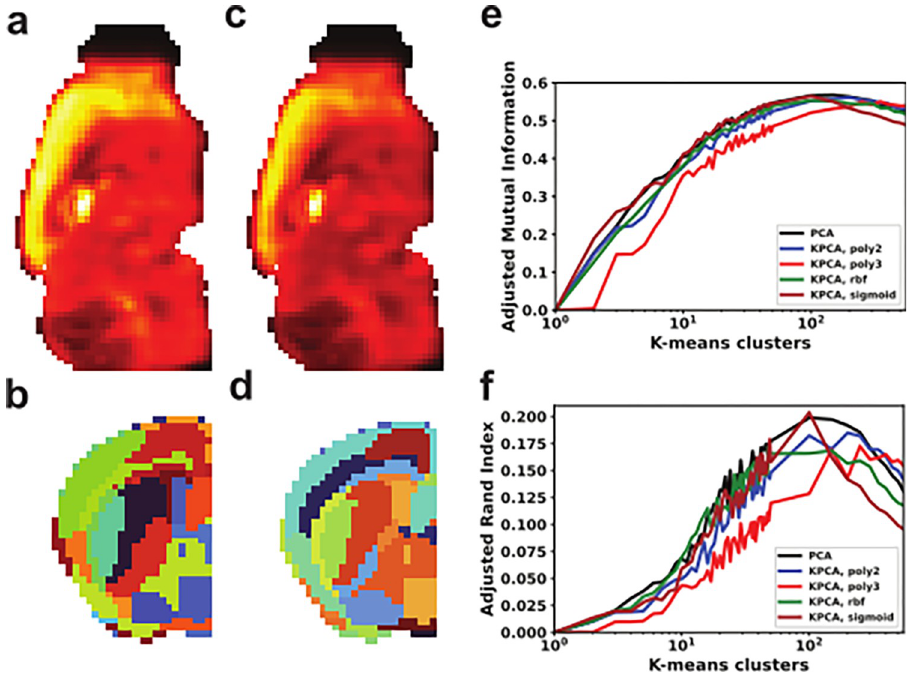
Fig 2. Linear and nonlinear PCA generate equivalent representations of anatomy from AMBA. (a) First PCA component representation in a sagittal slice. (b) Representation of K-means clustering (K = 200) of PCA components in a coronal slice of the left hemisphere. (c) First KPCA component with Quadratic kernel function in a sagittal slice. (d) Representation of K-means clustering (K = 200) of KPCA components with Quadratic kernel function in a coronal slice of the left hemisphere. (e, f) Adjusted Mutual Information and Adjusted Rand Index of clustered components using K-means clustering with K ranging from 1 to 50 and from 50 to 550 with a step of 50.